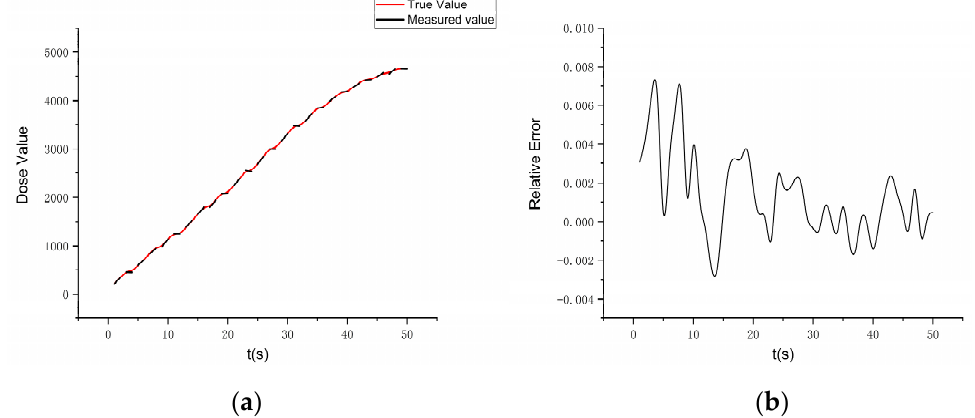
Figure 12. Analysis of radiation-detection data: ( a ) comparison of real radiation data with measured radiation data and ( b ) radiation-detection-data errors.